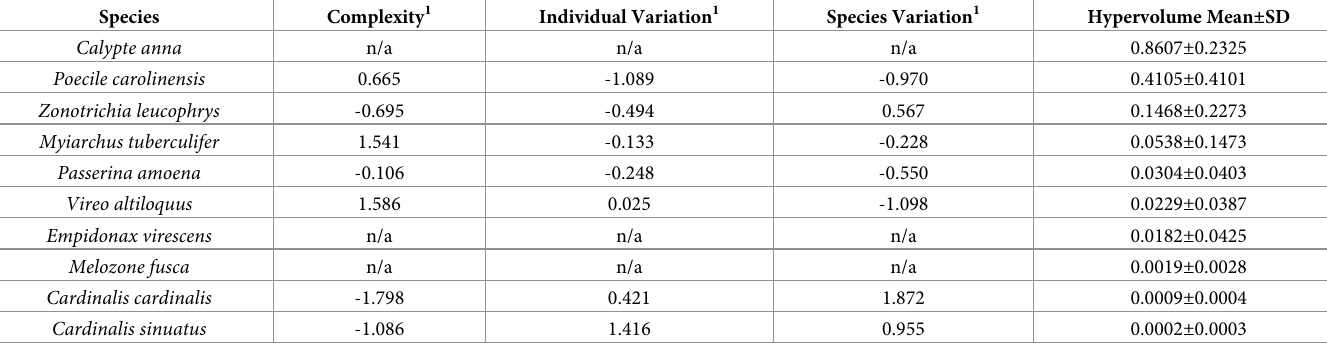
Table 3. Species vary with respect to song complexity, song variation, and hypervolume